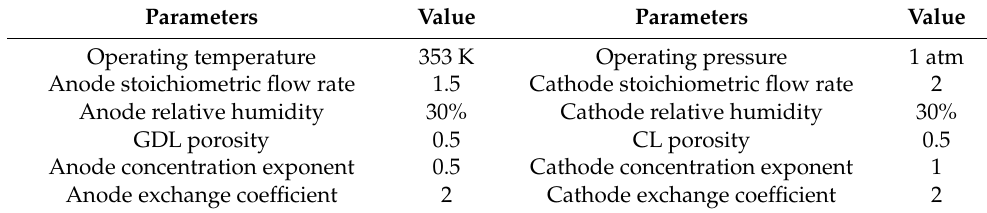
Table 2. Operating parameters.